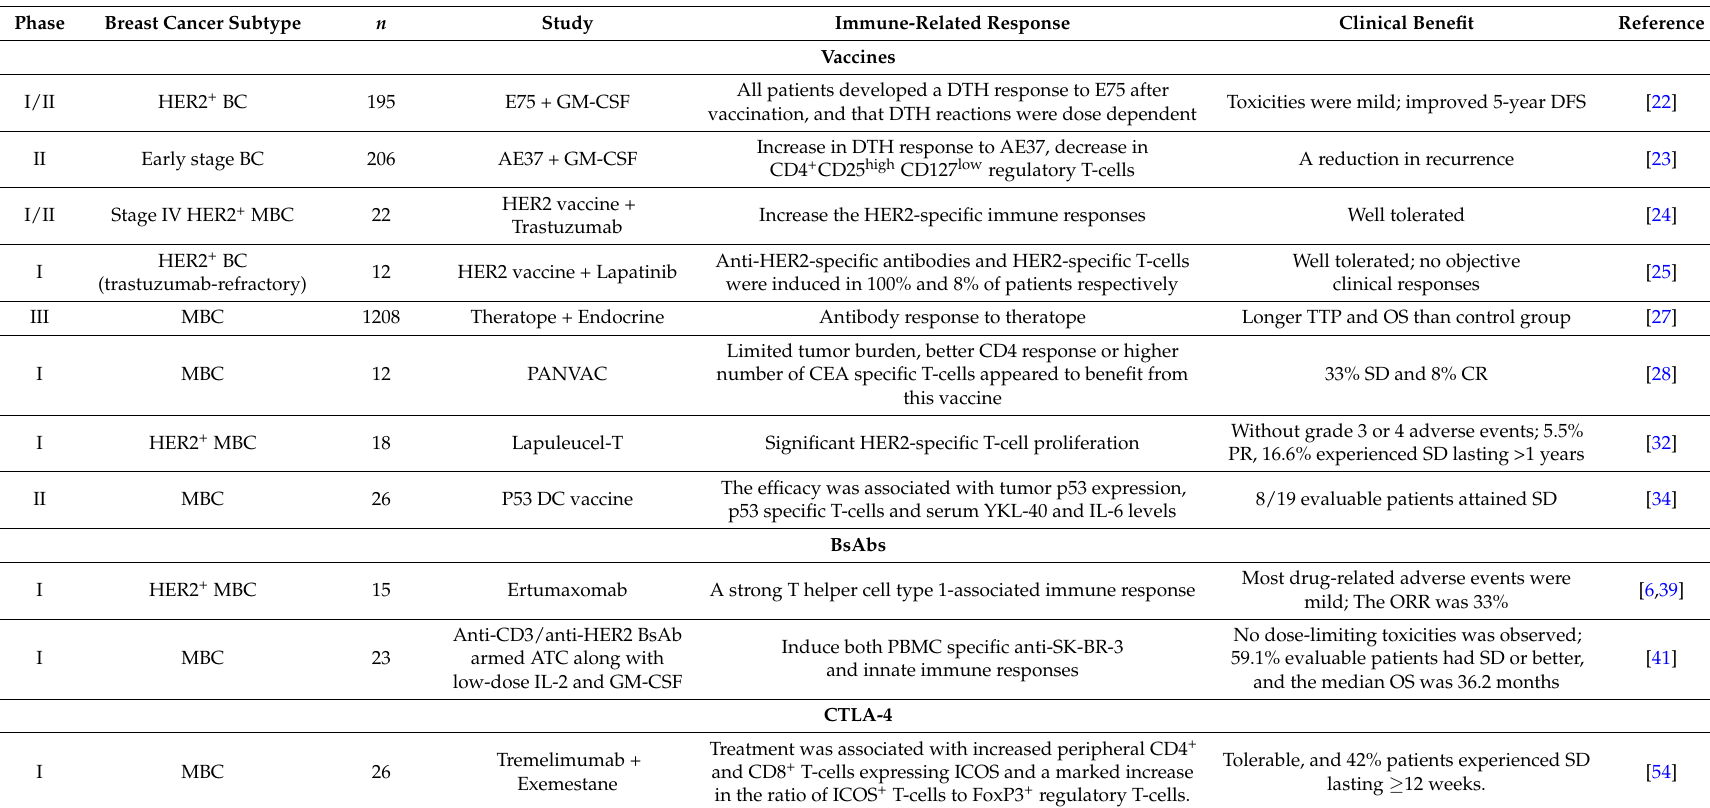
Table 2. Examples of completed clinical trials of immunotherapy in breast